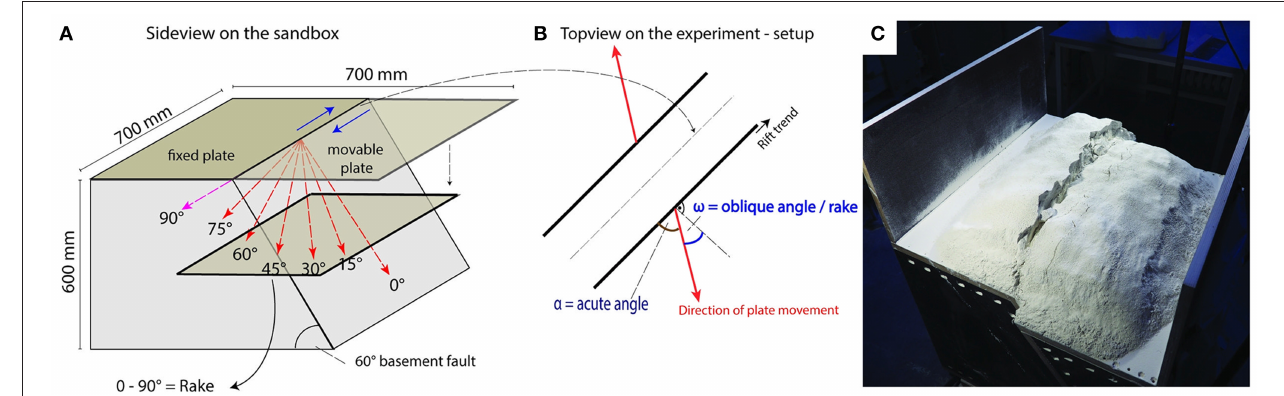
FIGURE 2 | Experimental setup. (A) The box consists of a stable block and a hangingwall block that can move at different obliquities ranging from dip-slip to strike-slip. Angle of the of basement fault has been set to 60 ◦ . (B) In top view, the rift trend is parallel to the basement fault, obliquity ω is defined as the angle between dip direction of the basement fault and direction of plate movement (i.e., ω = 0 ◦ for dip-slip, and ω = 90 ◦ for strike-slip; a dip-slip fault has no or 0 ◦ of obliquity). (C) Example picture of an experiment with 45 ◦ obliquity. Note the box does not have sidewalls, and thus the fault is unencumbered by sidewall friction.